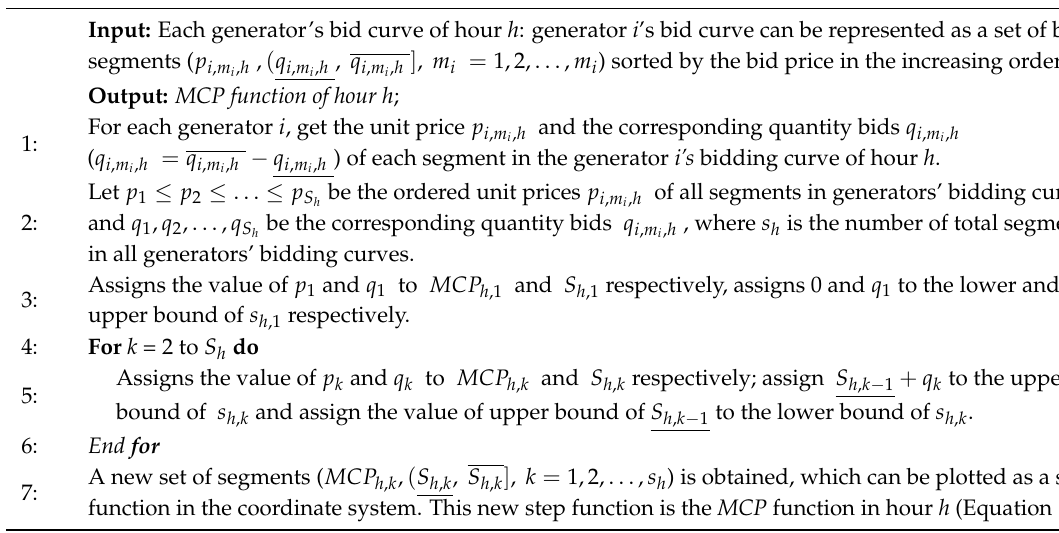
Algorithm 1 Calculate the MCP function of hour